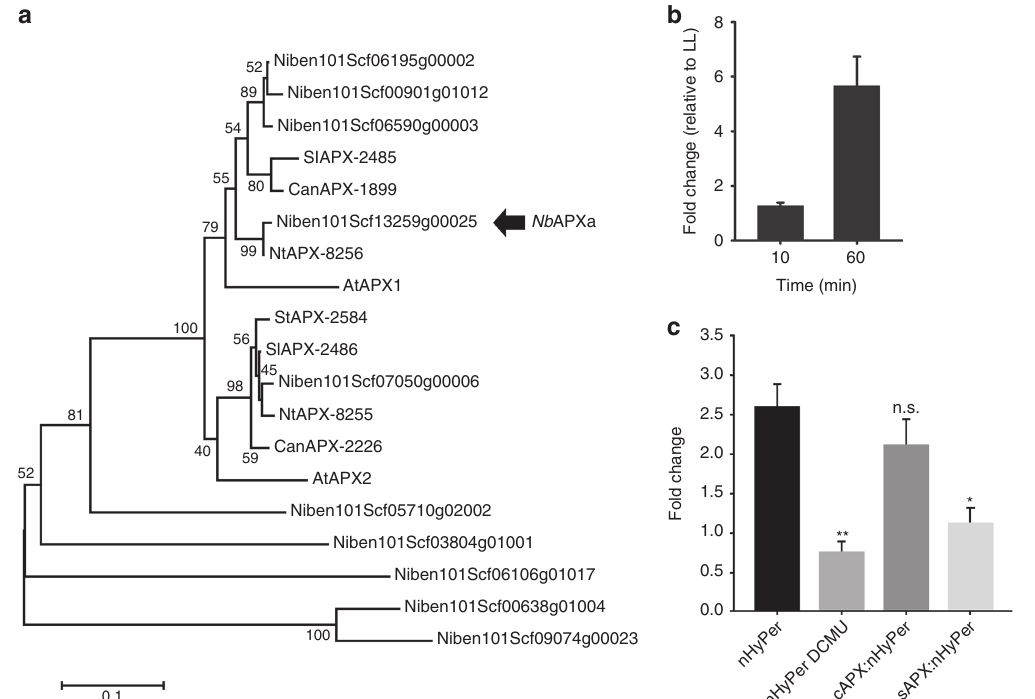
Fig. 4 The HL-responsive expression of an APX gene is dependent upon H 2 O 2 from the chloroplasts. a Neighbour-joining tree based on predicted amino acid sequences showing the phylogenetic relationships of putative APX genes from N. benthamiana (NiBen) Solanum lycopersicum (Sl), (Can, Capsicum annuum) , Nt ( Nicotiana tabacum ), St ( Solanum tuberosum) . Sequences were extracted from PeroxiBASE. Numbers next to the names indicate the identi fi er in the database. The APX gene shown to be HL responsive is marked ( Nb APXa). Bootstrap values (1000 replicates) are displayed near the nodes. The scale indicates the number of nucleotide substitutions per site. b Steady state levels of NbAPXa RNA leaves of N. benthamiana after 10 min and 60 min exposure to HL relative to a low light (LL) control. c Steady state levels of NbAPXa RNA leaves of N. benthamiana after 60 min exposure to HL relative to a LL controls. All leaves expressed nHyPer2 and a proportion of them were additionally treated with DCMU (10 µ M for 20 min prior to illumination) or co-expressed sAPX or cAPX. The nHyPer2 expressing LL controls were treated in the same way. The values are the means ± SEM ( n = 8) plants from two experiments. Signi fi cant differences (one way ANOVA) between the HL exposed leaves and those also expressing sAPX or treated with DCMU are denoted by **( P = 0.004) and *( P = 0.01); n.s. is not signi fi cant ( P >